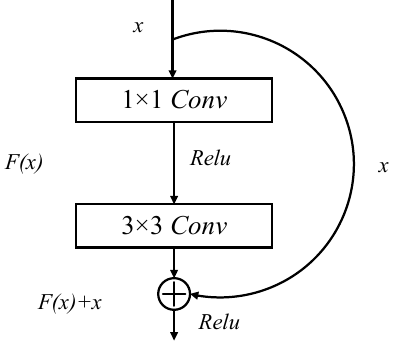
Figure 2. Residual